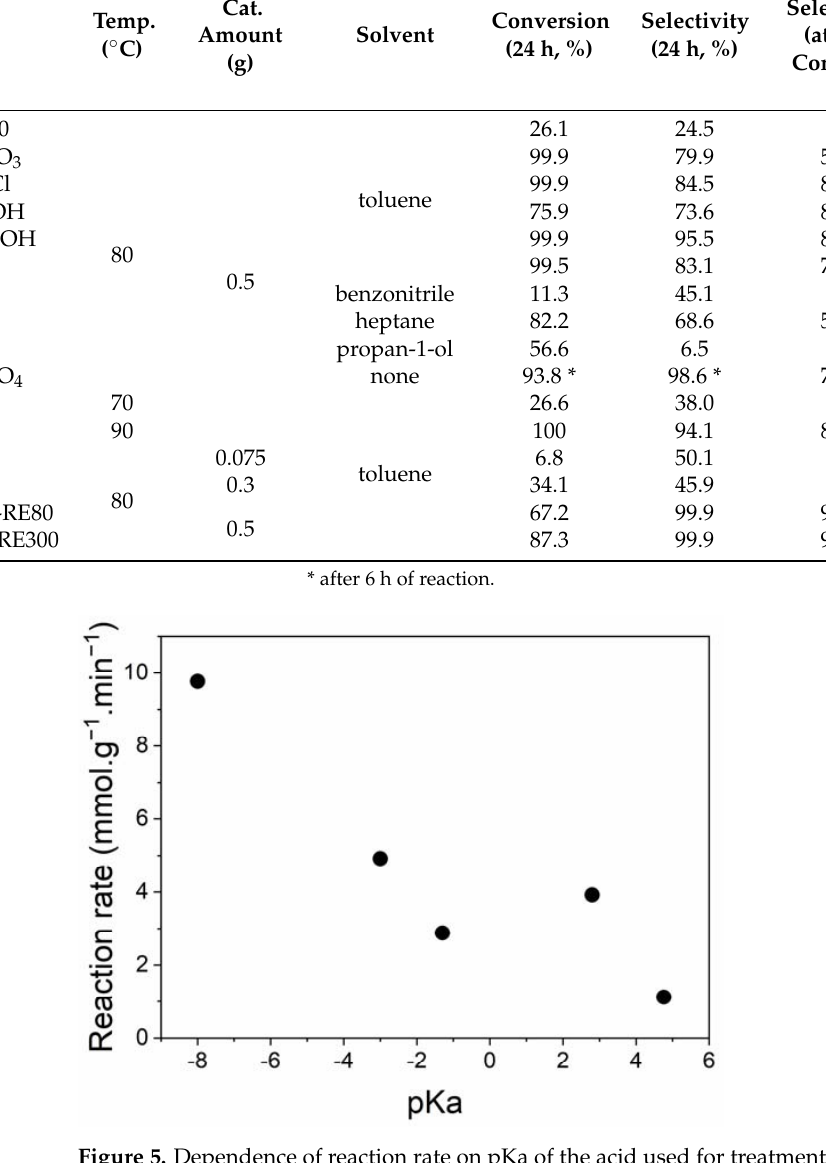
Figure 5. Dependence of reaction rate on pKa of the acid used for treatment. We have not found the connection between either total acidity or strong acidity of materials and the reaction rate (Figure S4). Two undesired products occurred in the reaction mixture. 8-hydroxycarvone and dicarvone (Figure 6), beside the desired product.